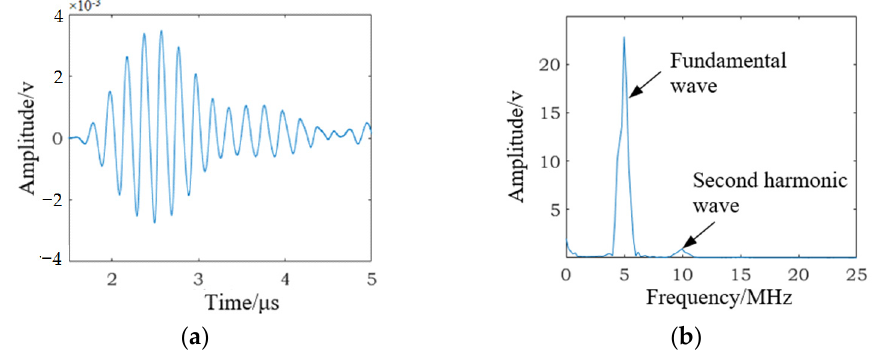
Figure 5. The SLM 316 L stainless steel specimen not subjected to fatigue cycles. ( a ) The received time ‐ domain signal. ( b ) The frequency spectra of the received signal.